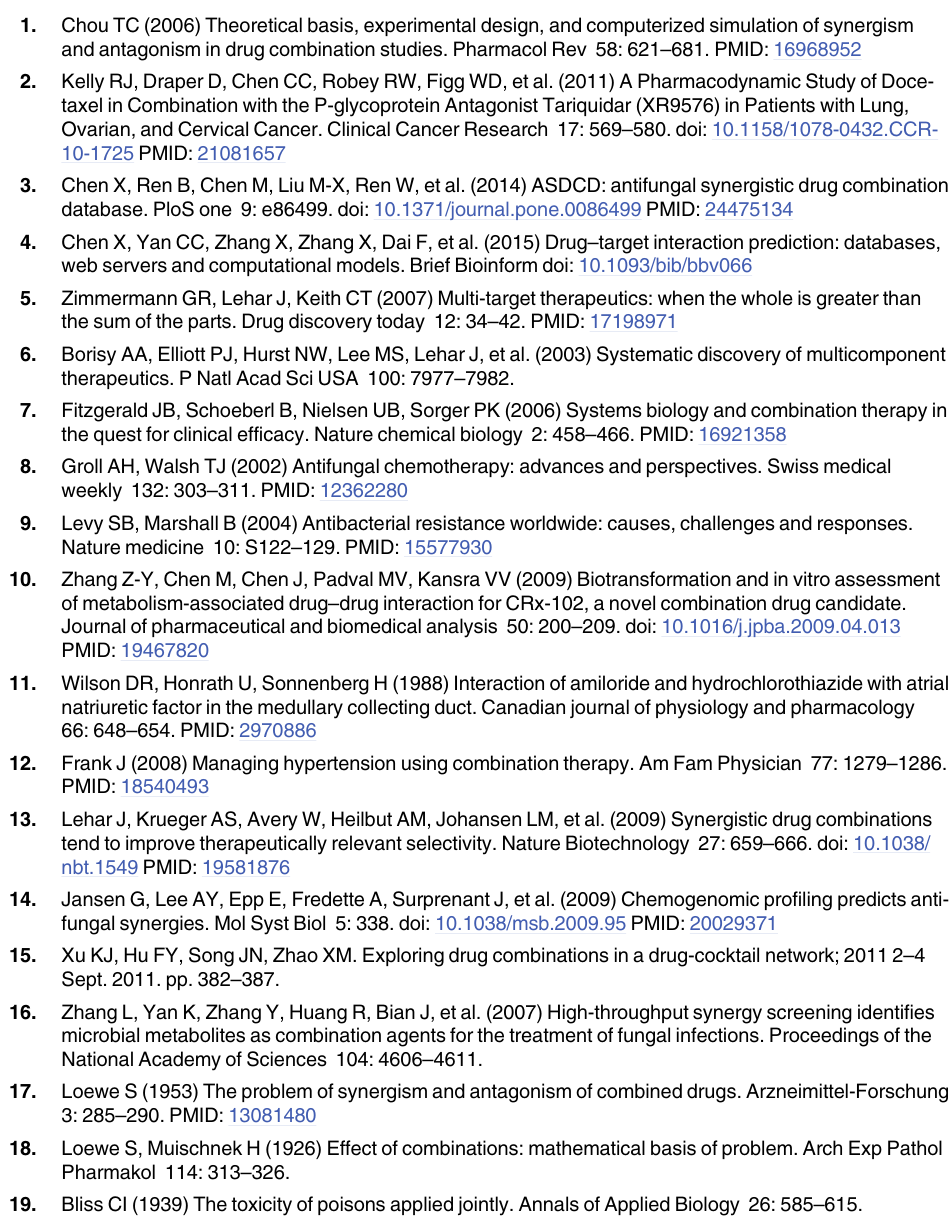
S26 Table. MICs data for the synergistic antifungal combinations and their FIC index at different time